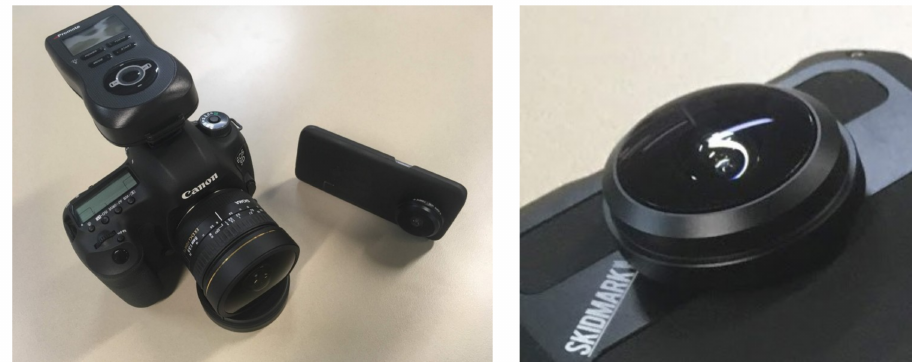
Figure 4. Two capturing devices (DSLR camera and Samsung S7 phone) with fisheye lenses. The